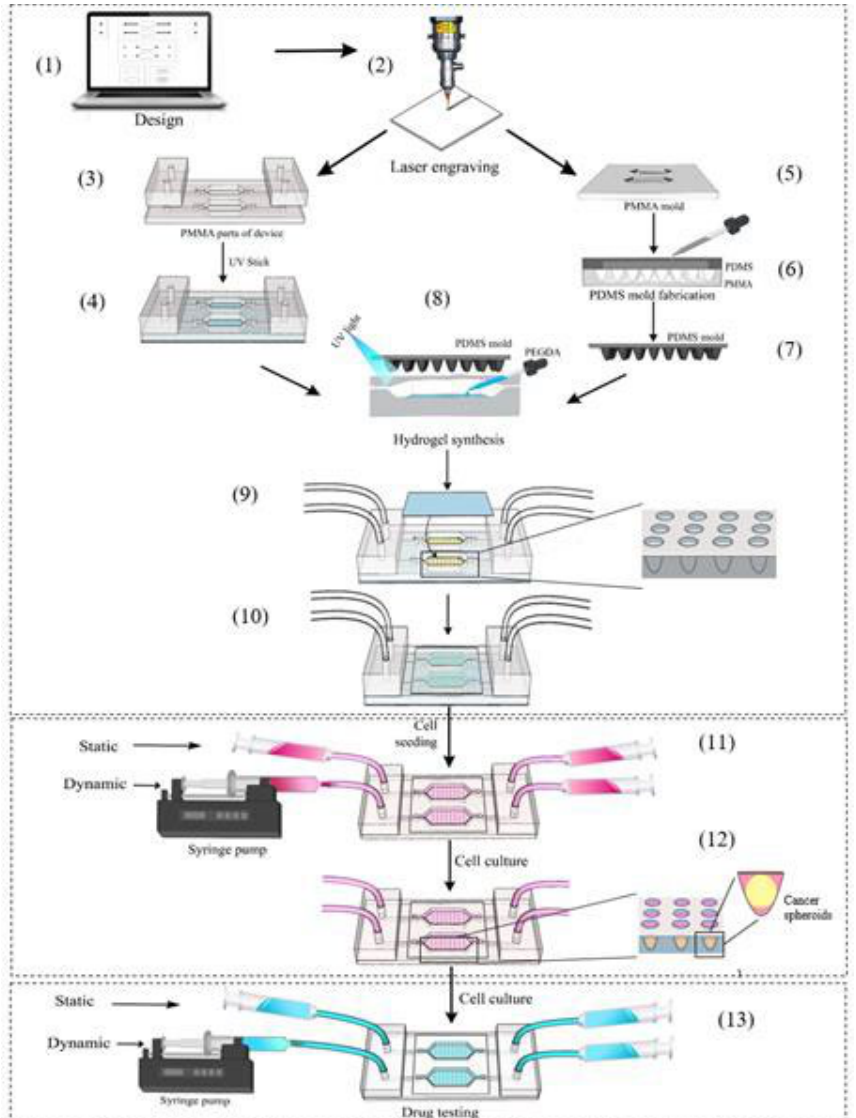
Figure 1. The fabrication of the microfluidic device with all sequential steps. ( 1 ) The PMMA components of the microfluidic device and the PMMA mold of the microwell were designed. ( 2 ) The PMMA sheets were laser cut and engraved according to the design. ( 3 ) The PMMA layers of the device were machined, and ( 4 ) they were attached with a UV stick. ( 5 ) The PMMA mold was formed. ( 6 ) The polydimethylsiloxane (PDMS) solution was dropped into the PMMA mold to form the PDMS mold. ( 7 ) The PDMS mold was generated. ( 8 ) The PDMS mold was placed on top of the culture area containing the hydrogel mixture of the microfluidic platform. ( 9 ) Microwells were generated, and a 22 × 22 mm glass plate was mounted on top of the culture area. ( 10 ) The microfluidic device was completed and prepared for cell seeding. ( 11 ) Cells were seeded into the well and then cultured in an incubator. ( 12 ) During the culture, cells aggregated and formed spheroids in the microwell. ( 13 ) After successful culture, the spheroids were used for drug testing.